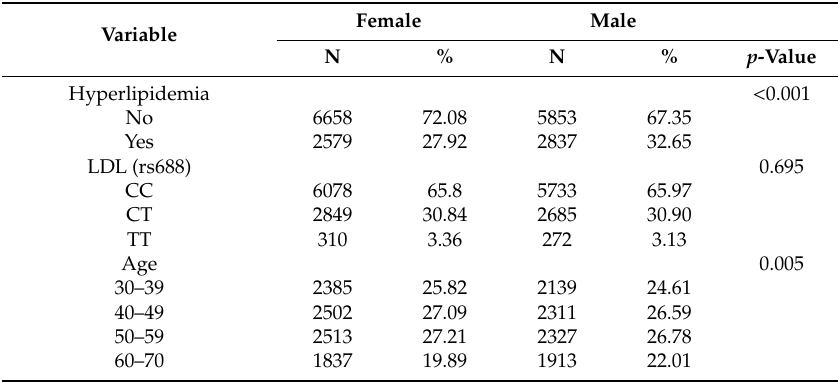
Table 1. Descriptive data of the participants by